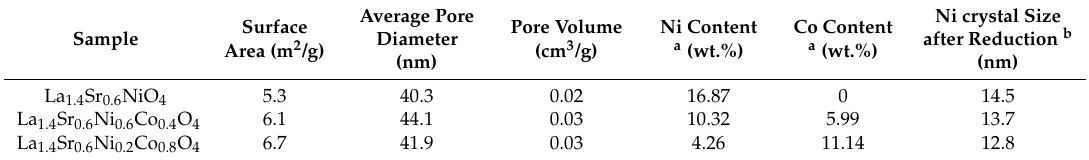
Table 2. Physical properties of oxygen